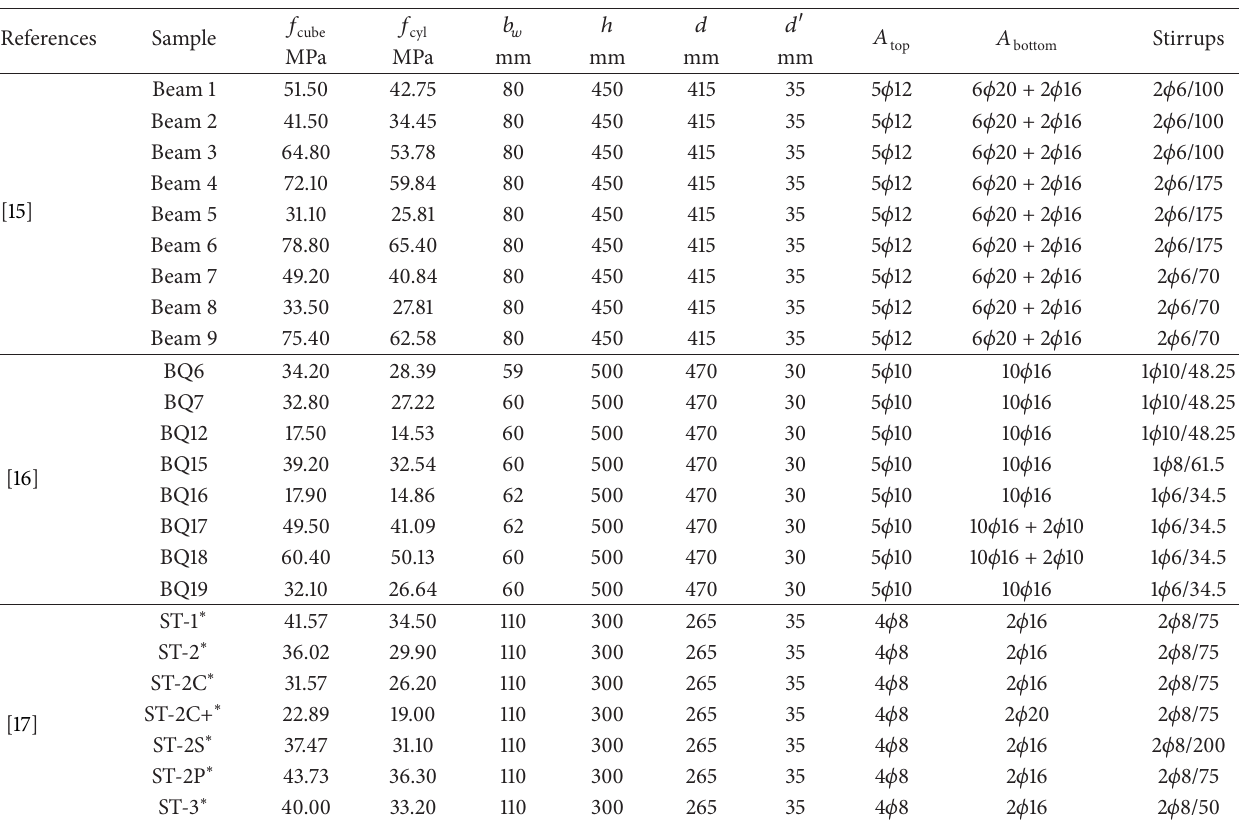
Figure 3: Stress equivalence in the beam section. Compressive and tensile stress resultants. Table 1: Geometric properties of the reference